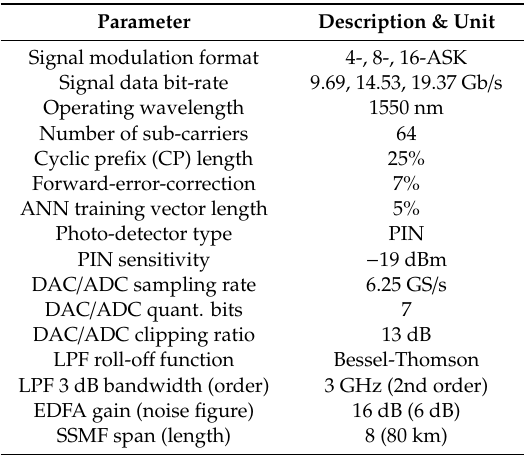
Table 1. Key optical Fast-OFDM transceiver parameters.